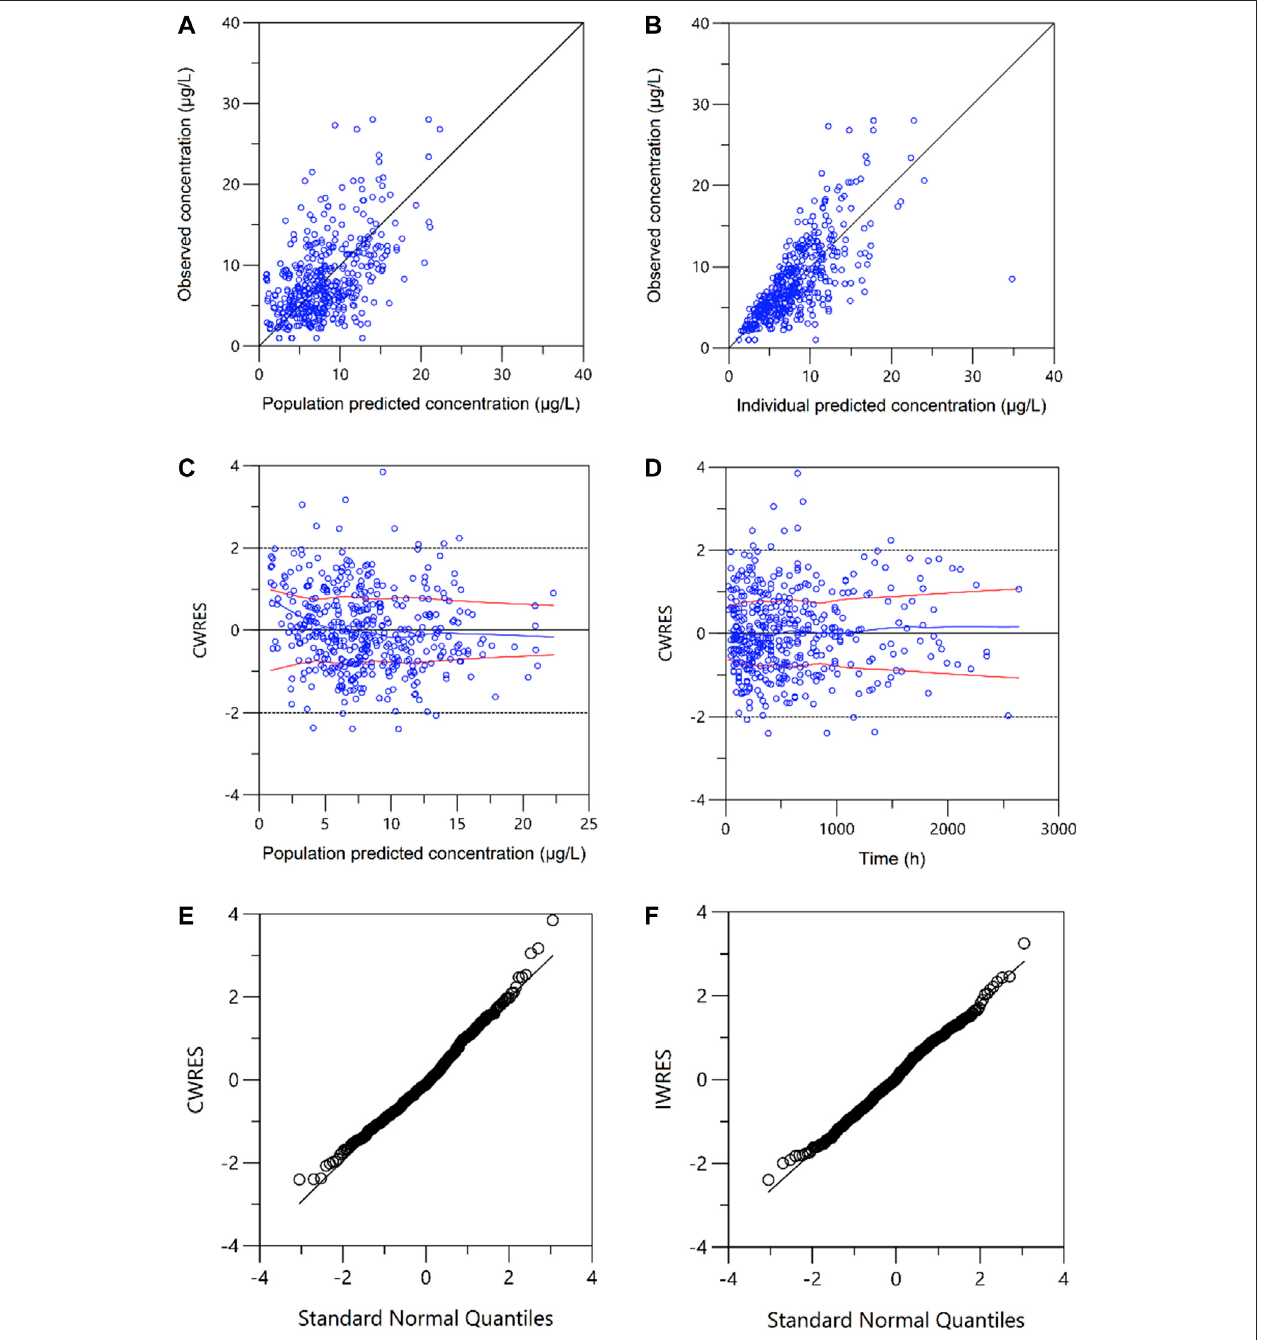
FIGURE 1 | Plotsofthegoodnessof fi t. (A) Observedversuspopulation-predictedconcentrations(DVvs.PRED); (B) Observedversusindividual-predictedconcentrations (DV vs. IPRED); (C) Conditional weighted residuals versus population-predicted concentrations (CWRES vs. PRED); (D) Conditional weighted residuals versus time (CWRES vs. IVAR). (E) Conditional weighted residuals (CWRES) versus standard normal quantiles. (F) Individual weighted residuals (IWRES) versus standard normal quantiles.